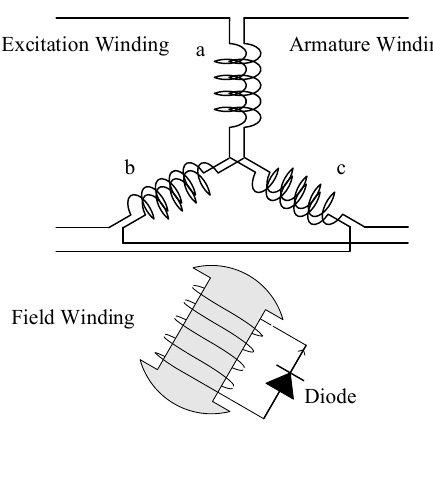
Figure 1. Winding configuration.